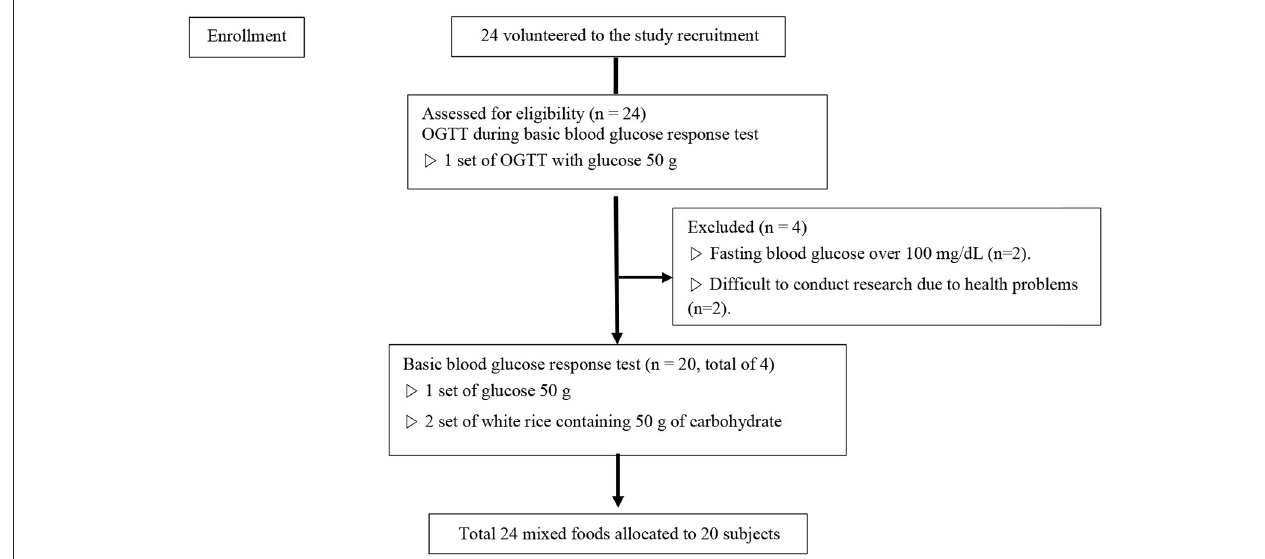
FIGURE 1 | Flow chart of study